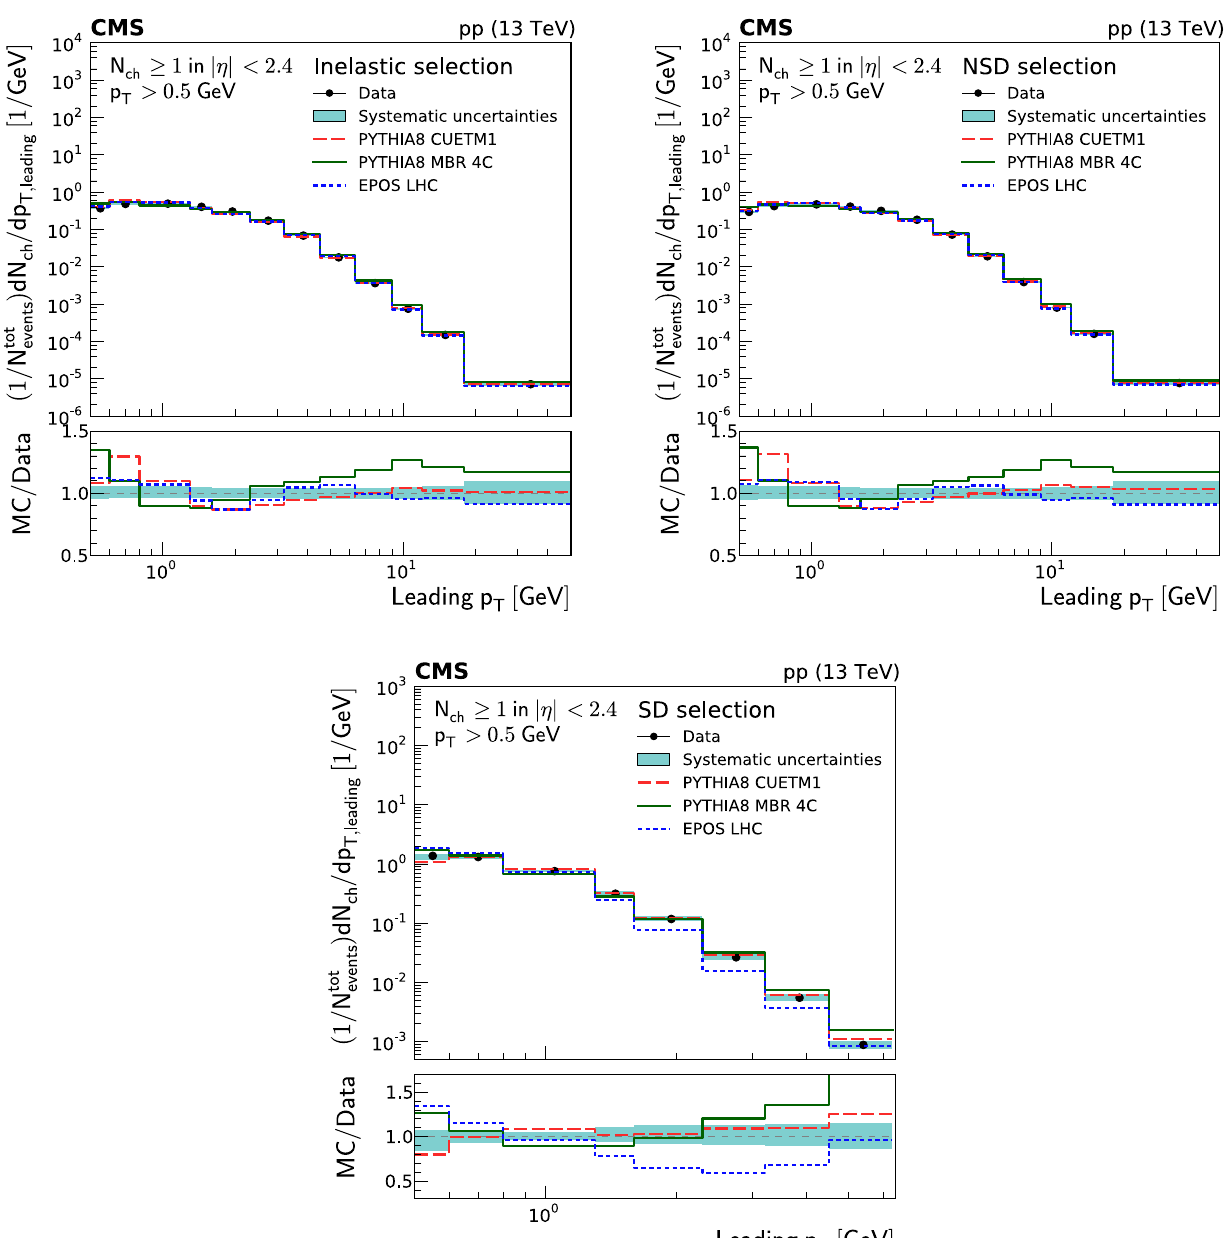
Fig. 5 Leading charged particle p T distributions of inelastic (top left), NSD-enhanced (top right), and SD-enhanced (bottom) event samples. The measurements are compared to the predictions of the pythia 8 cuetm1 (long dashes), pythia 8 mbr4c (continuous line), and epos